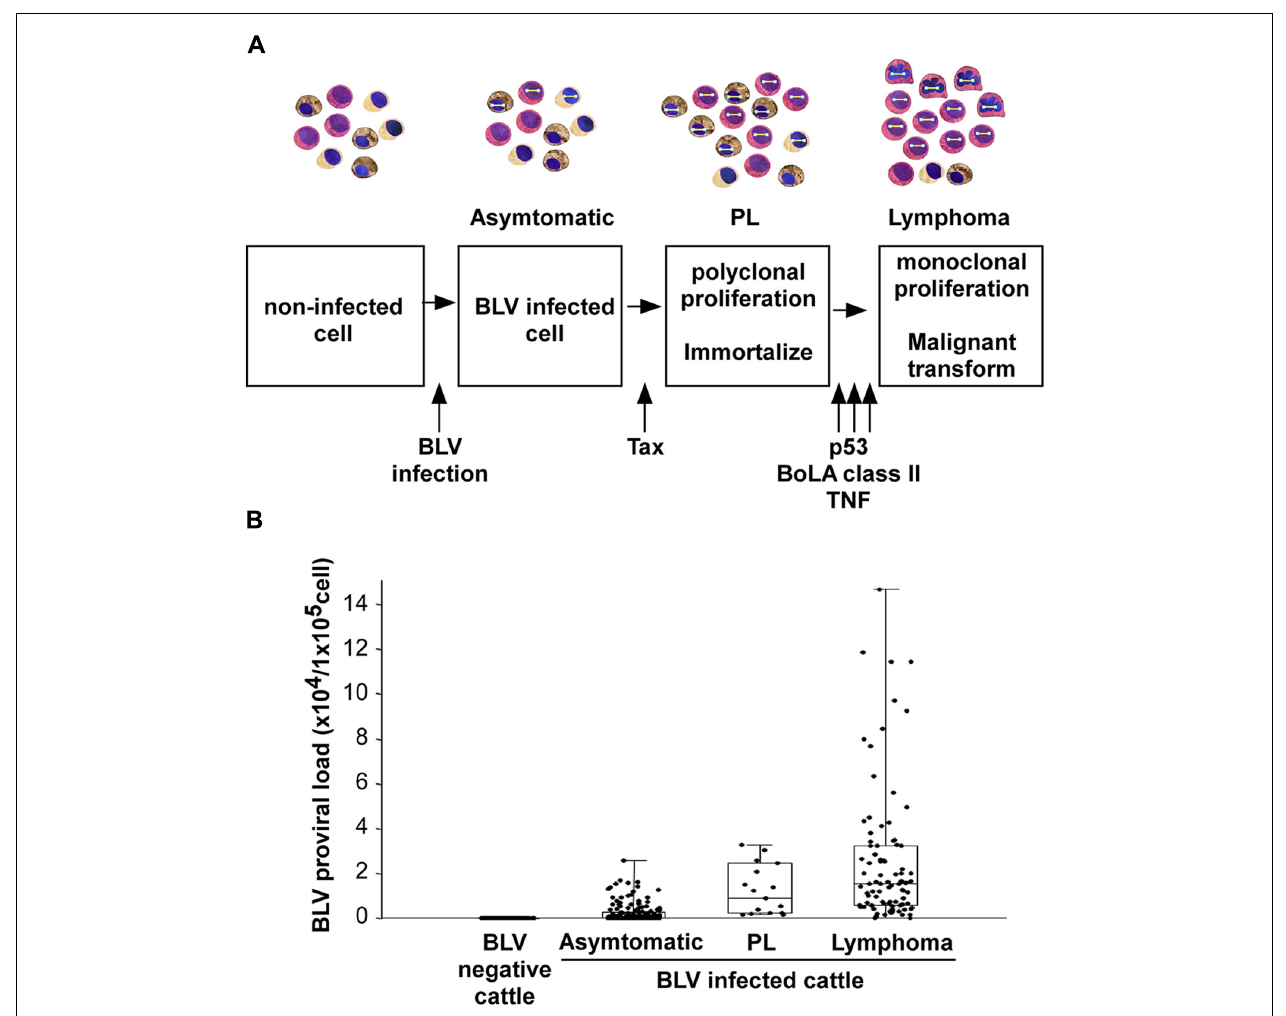
FIGURE 2 | BLV-induced leukemogenesis is a multistep process. (A) An infection with BLV is characterized by three progressive stages of disease: asymptomatic stage, persistent lymphocytosis (PL), and lymphoma. BLV infects to cells non-specifically. Among them, BLVTax protein immortalizes a part of BLV-infected cells, probably only CD5 + IgM + B-cells, and induces